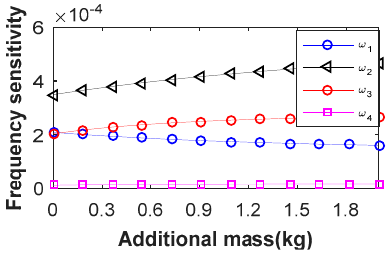
Figure 10. Relative sensitivity of the first four frequencies with different mass for substructure 7.